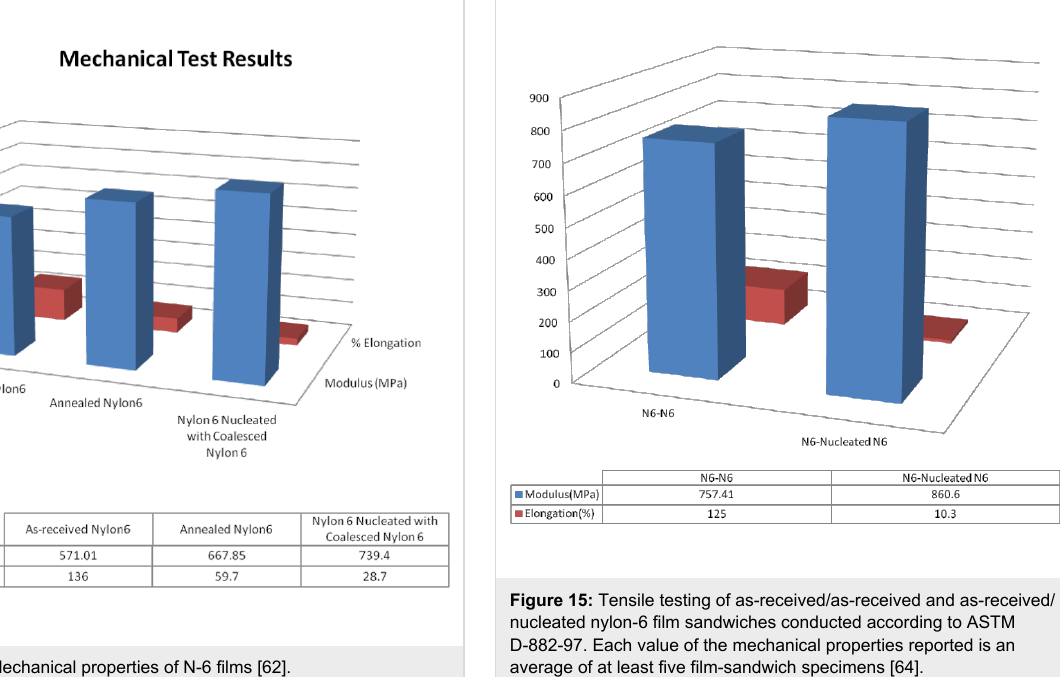
Figure 14: Mechanical properties of N-6 films [62].